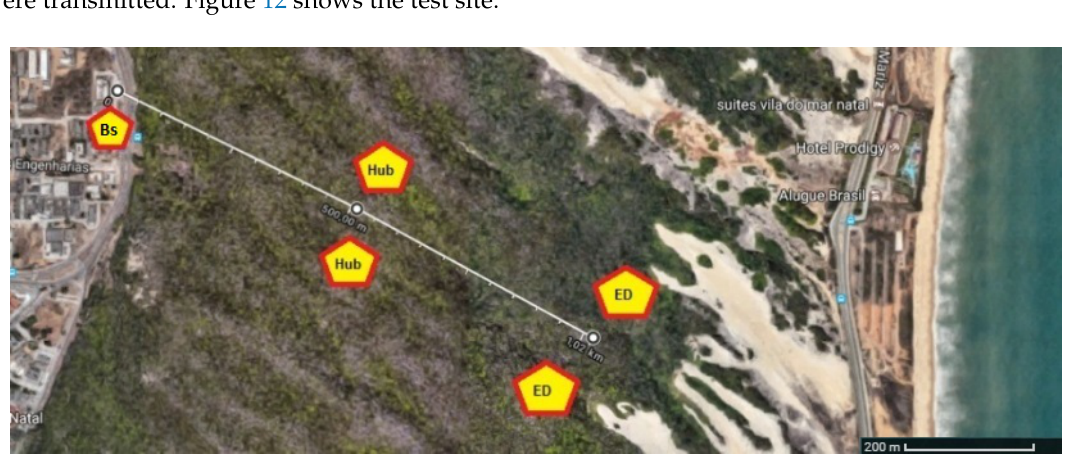
Figure 12. Test site and position of UAVs.